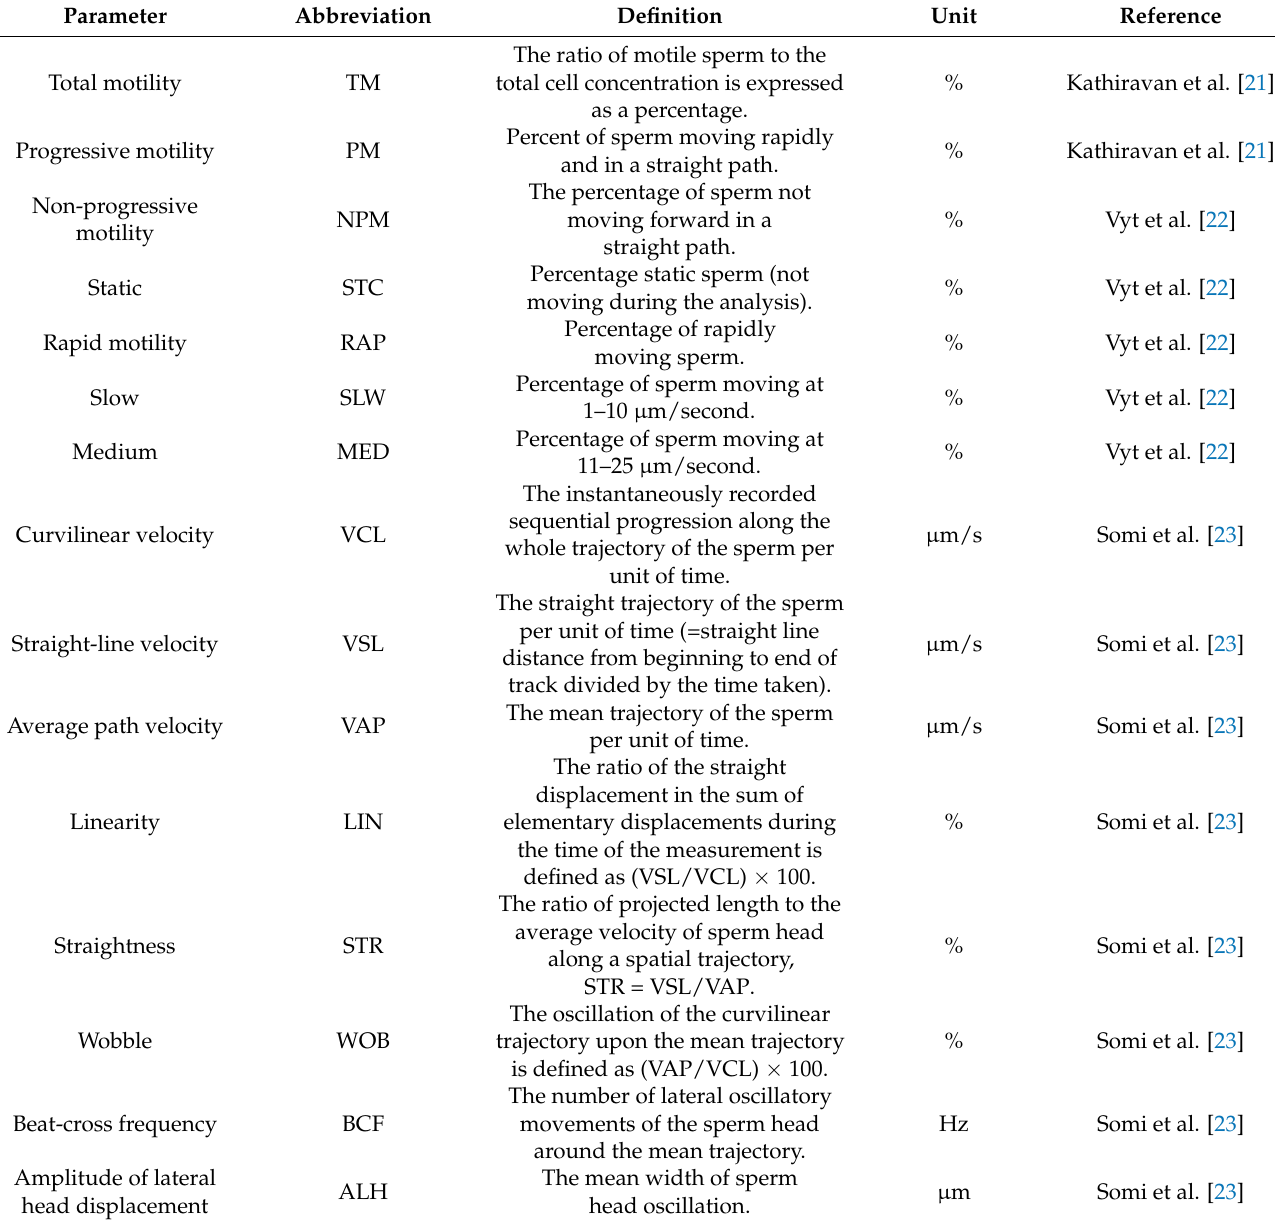
Table 1. The detailed description of the CASA—Sperm Class Analyzer ®